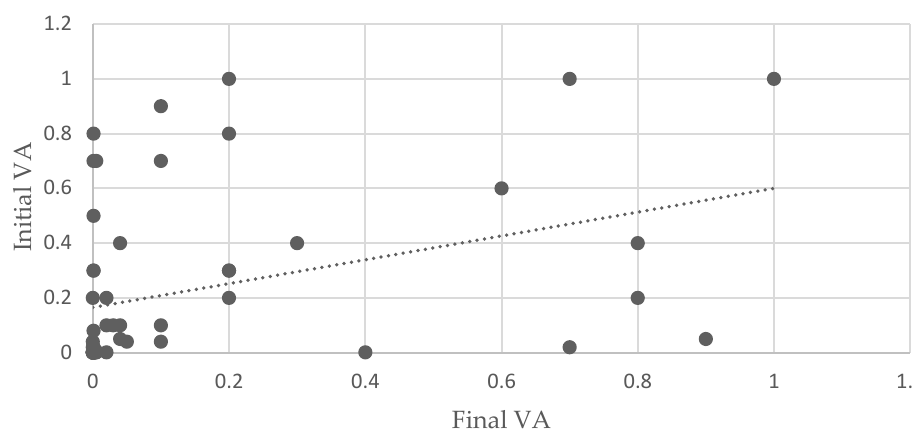
Figure 3. Distribution of initial BCVA vs. final BCVA. BCVA= Best corrected visual acuity.